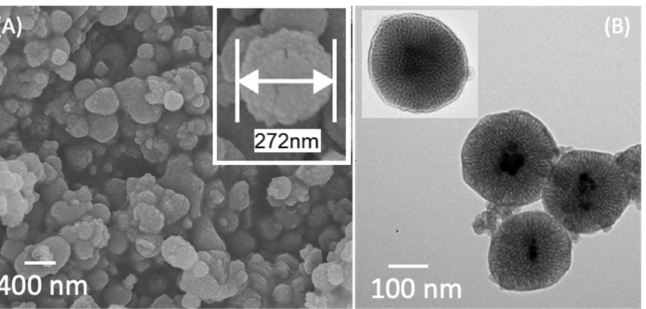
Figure 2. ( A ) SEM image and ( B ) TEM images of magnetic mesoporous silica nanoparticles coated with